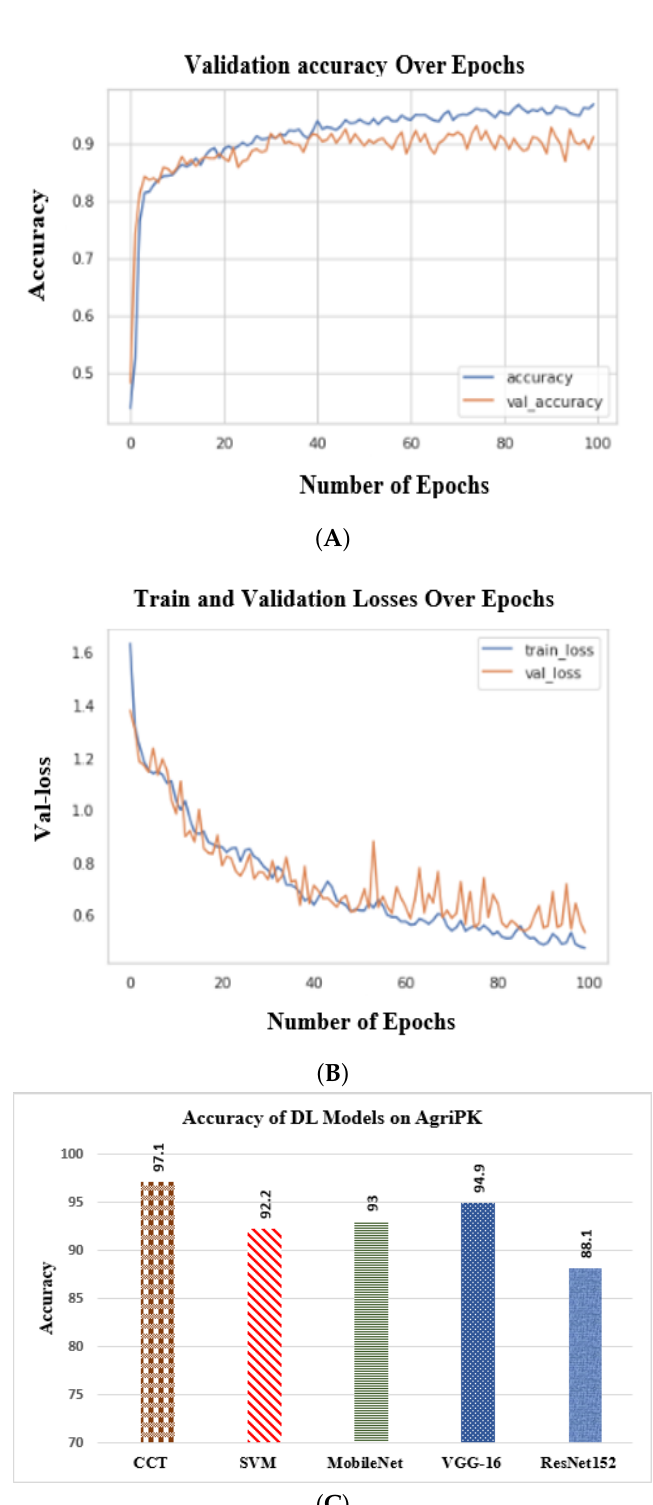
Figure 6. ( A ) Validation accuracy over epochs. ( B ) Training and validation loss epochs. ( C ) Accuracy of all DL